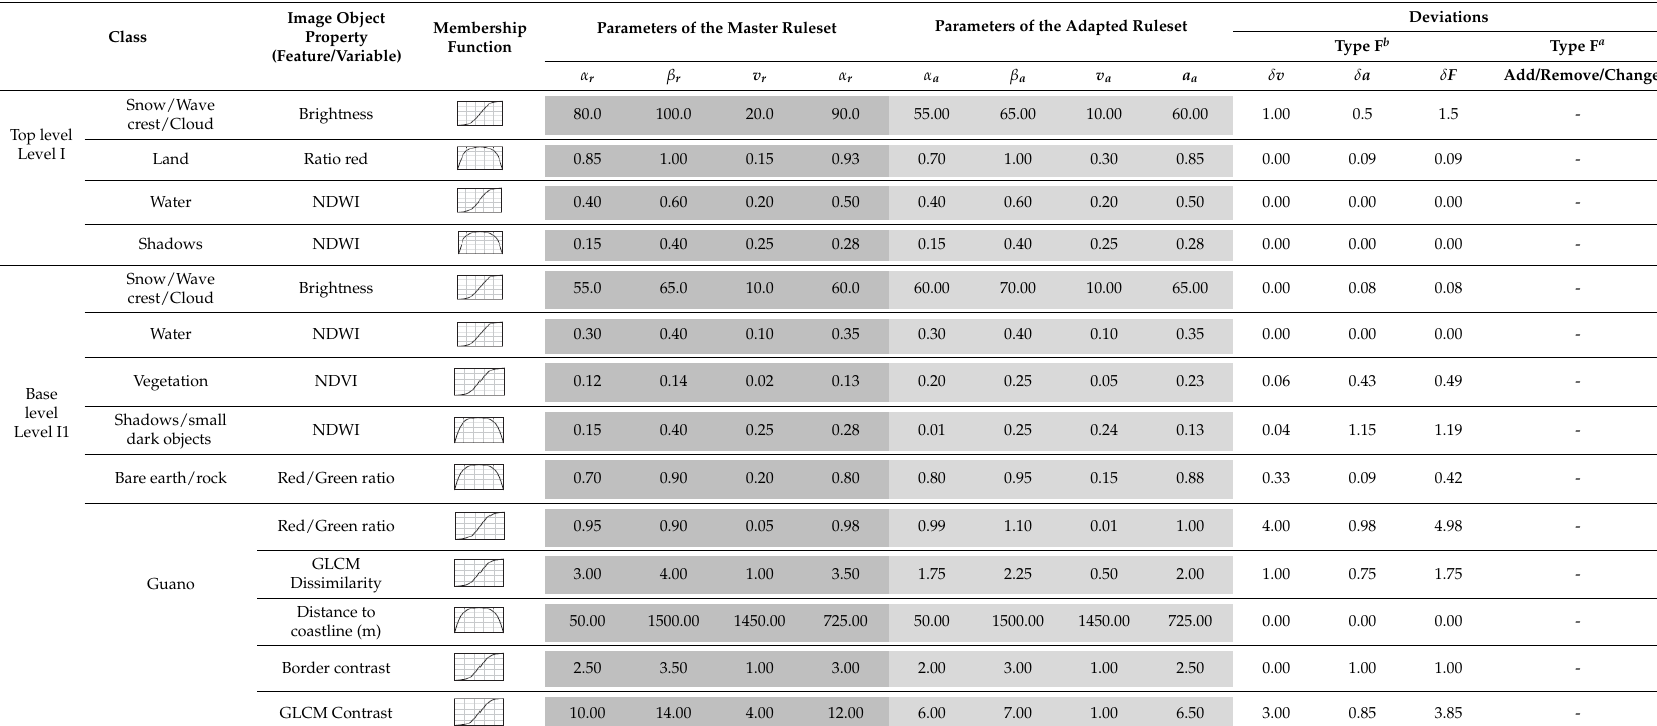
Table 4. Ruleset adaptation from HOPE to AITC.